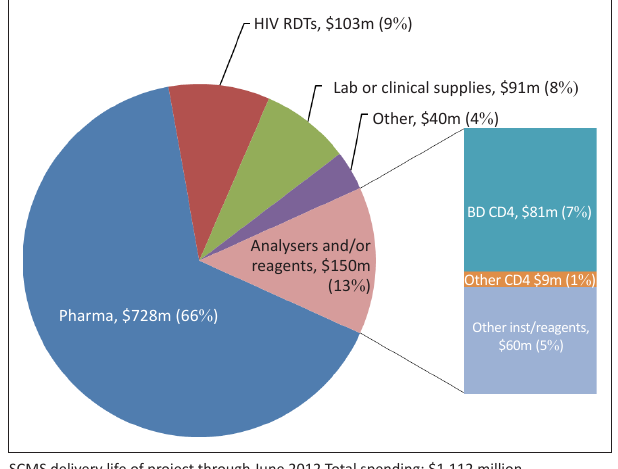
FIGURE 1: Partnership for Supply Chain Management (PFSCM) total spending as of June 30, 2012. PFSCM historical procurement data were used to determine the total expenditures for the Supply Chain Management Systems Life of Project (LOP). All figures represent the value of delivered commodities in US dollars from September 2005 to June 2012. Data are categorised into pharmaceuticals (Pharma [66 % ], HIV RDTs [9 % ], Analysers and/or reagents [13 % ], Lab/clinical supplies [8 % ] and Other [4 %